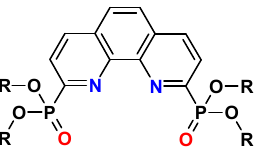
Figure 17. (1,10-phenanthrolin-2,9-diyl)phosphonate POPhen , R = Et − C2-POPhen, R = Bu − C4-POPhen .